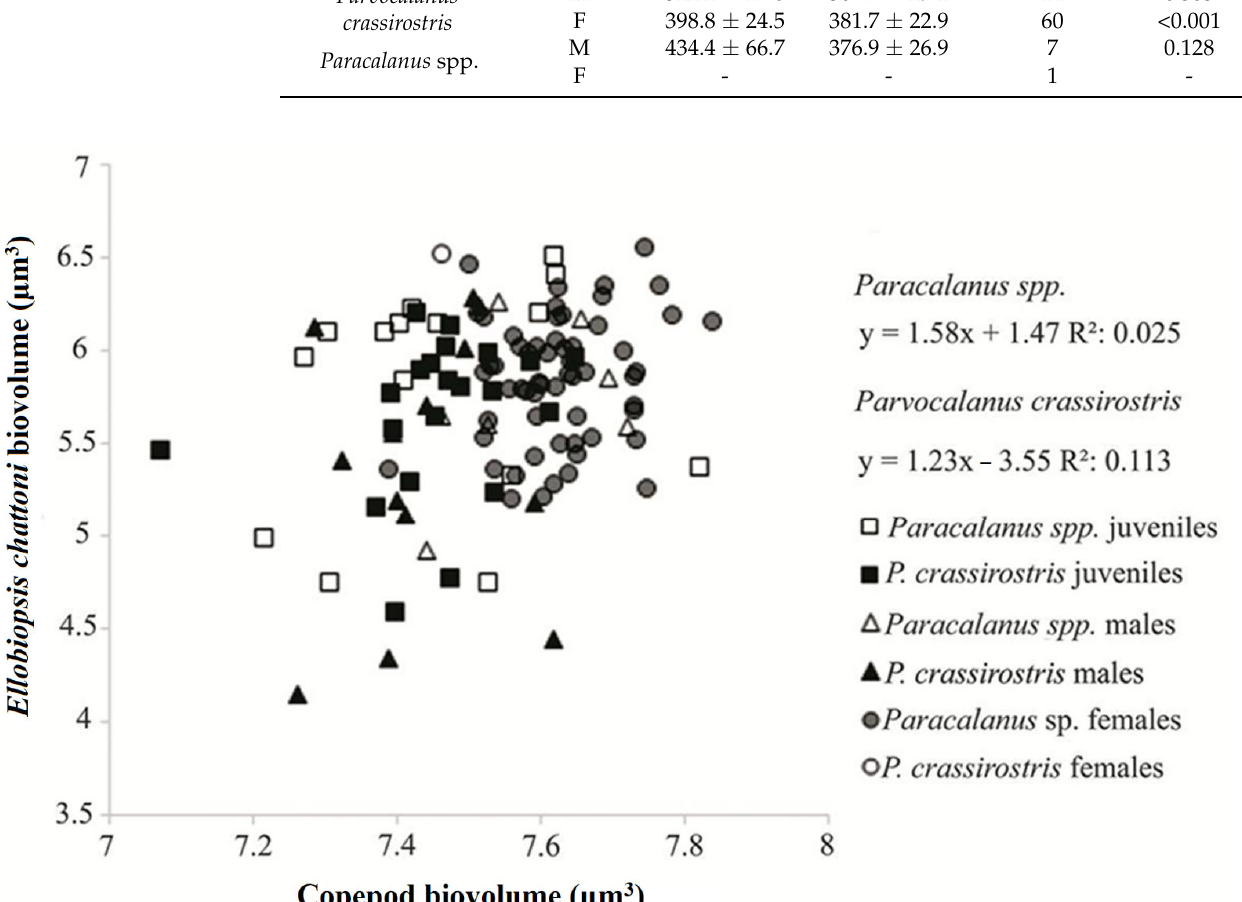
Figure 2. Relationship between the biovolume ( µ m 3 , log scale) of infected paracalanid copepods ( Paracalanus spp. and Parvocalanus crassirostris ) and the respective attached Ellobiopsis chattoni parasites.